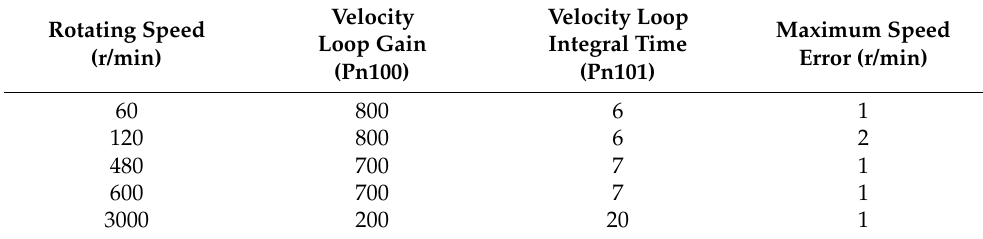
Table 1. Motor speed error at different speeds.